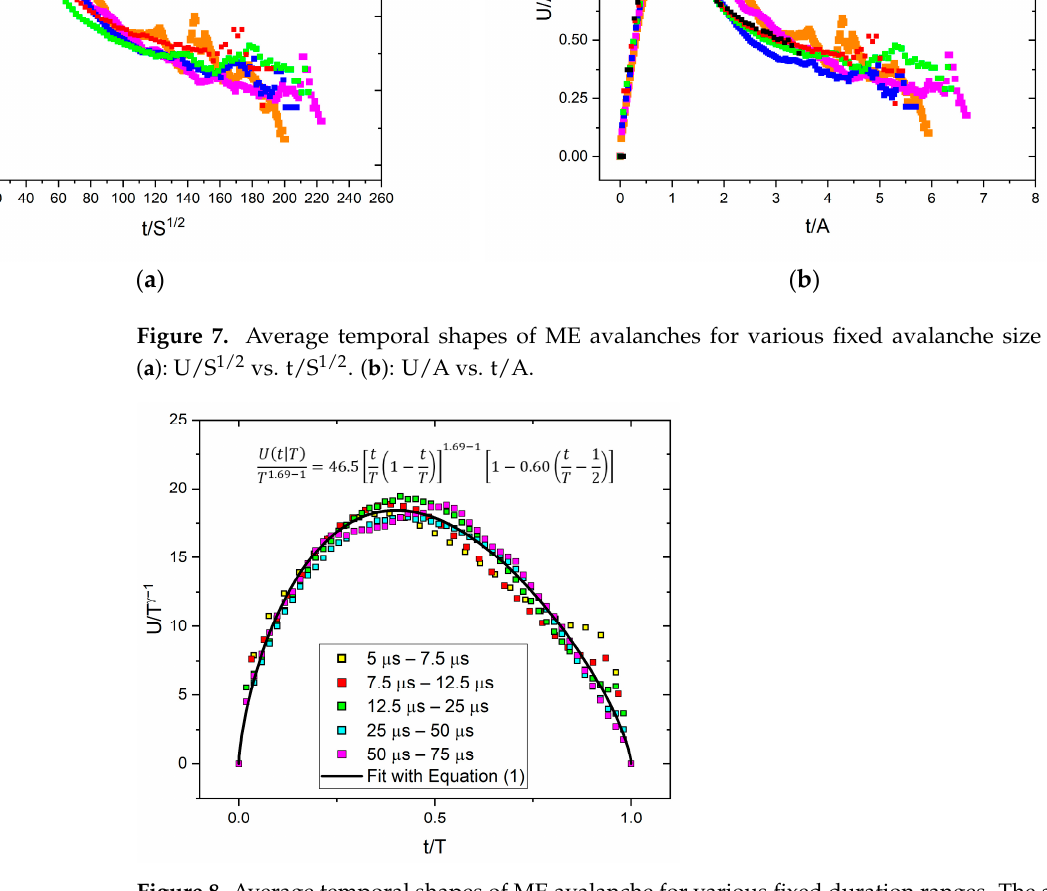
Figure 8. Average temporal shapes of ME avalanche for various fixed duration ranges. The average of the curves was fitted according to Equation (1), resulting γ = 1.69 and b = 0.60.